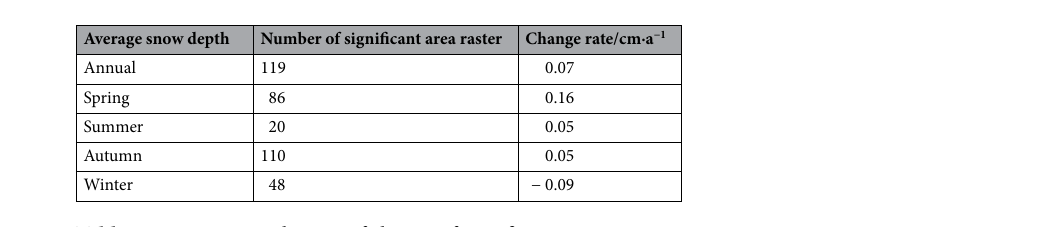
Table 6. Statistics on the rate of change of significant areas.